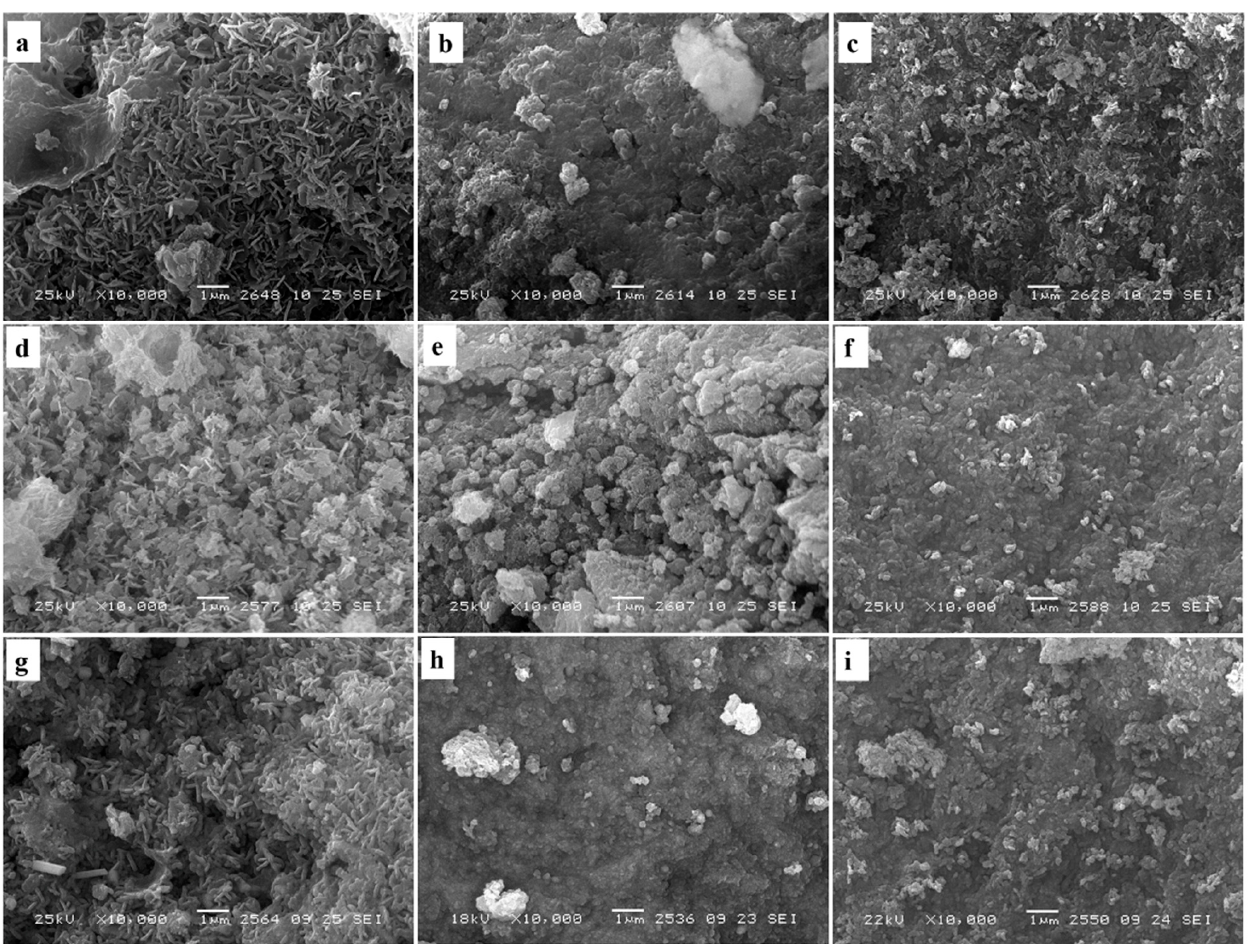
Figure 3. SEM images of CuAl ( a , d , g ), CuCoAl ( b , e , h ), and CoAl ( c , f , i ) samples in the forms of as-prepared LDHs ( a – c ), mixed oxides after calcination at 550 °C ( d – f ), and mixed oxides after